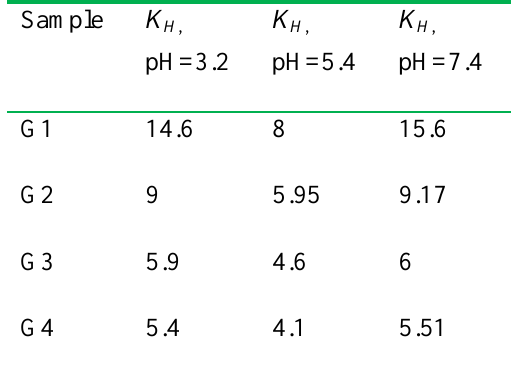
Table 5. Huggins constants of the investigated systems at different pHs.